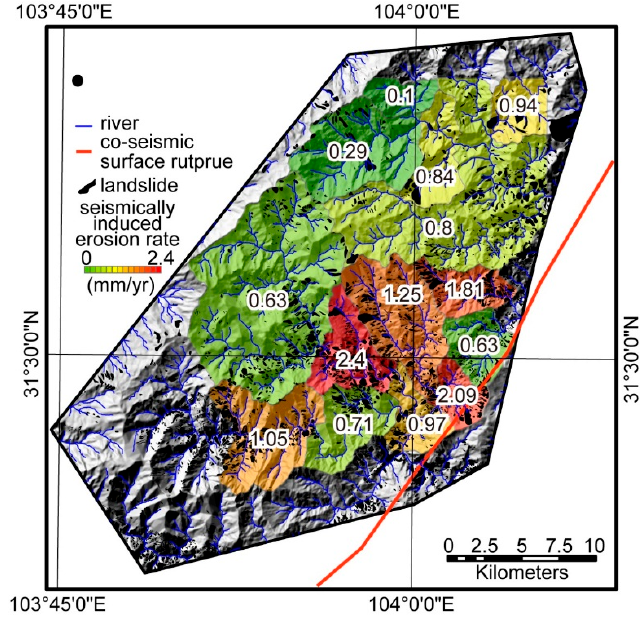
Figure 3. The seismically-induced erosion rates derived using the differential DEM method shown within the area covered by the high-resolution DEM. Erosion rates are calculated within small catchments by summing up the landslide volume using the elevation difference.